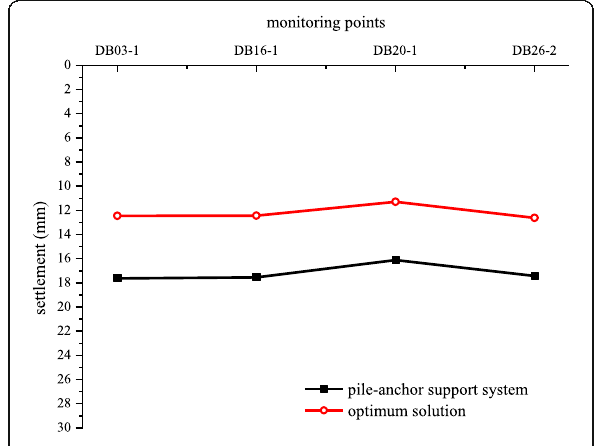
Fig. 12 Simulated settlement of two support Systems Fig. 13 Simulated lateral displacement of two support